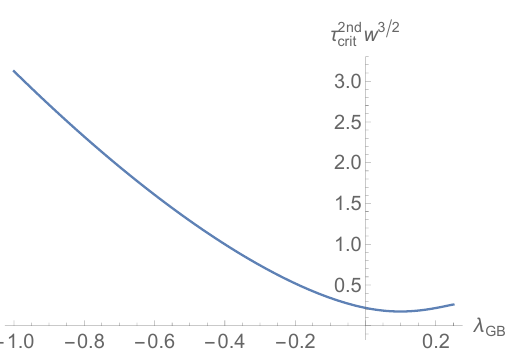
Figure 1 . Behavior of (cid:28) 2nd Negative values of (cid:21) weak